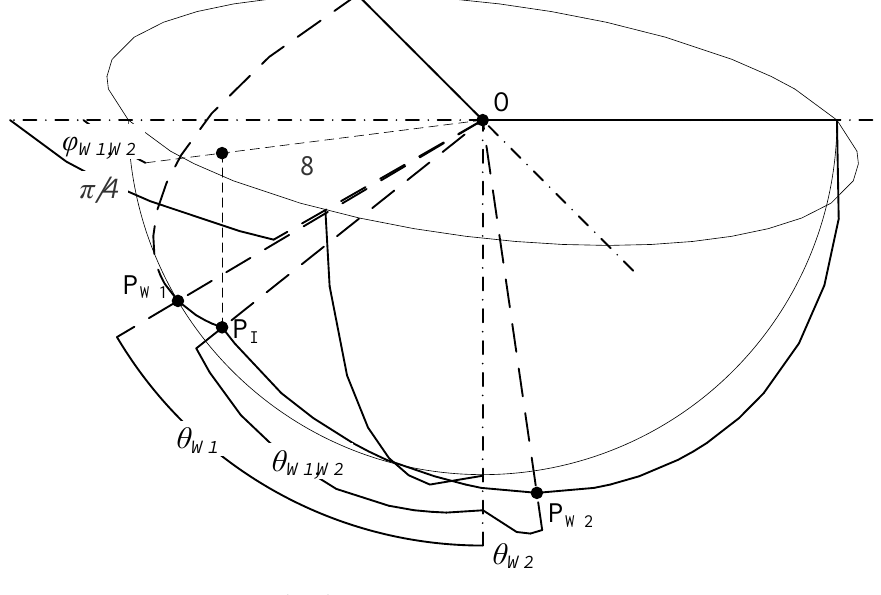
Figure A10. Ω W geometric Figure A10. Ω W geometric sketch. Figure A10. Ω W geometric sketch.